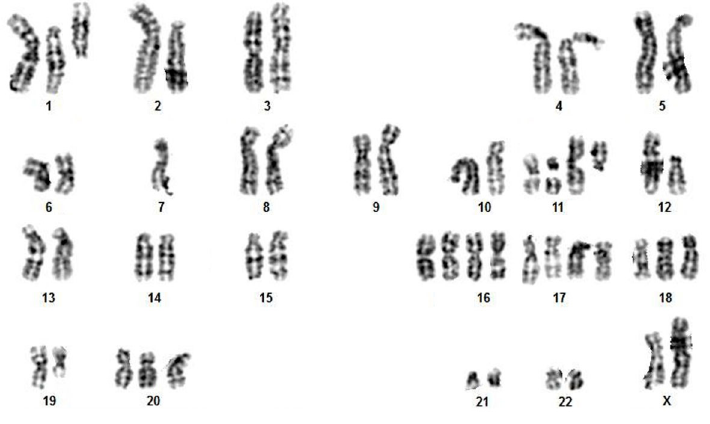
Figure 1. A representative G-banded metaphase of AHOL1 cell line, with 2n=54, XX, + der(1), + der(1), + der(2), del(6q), del(6q), – 7, + der(11), + der(11), del (11q), del(12p), + 16, + 16, + 17, + 17, + 18, del(19q), + der20.